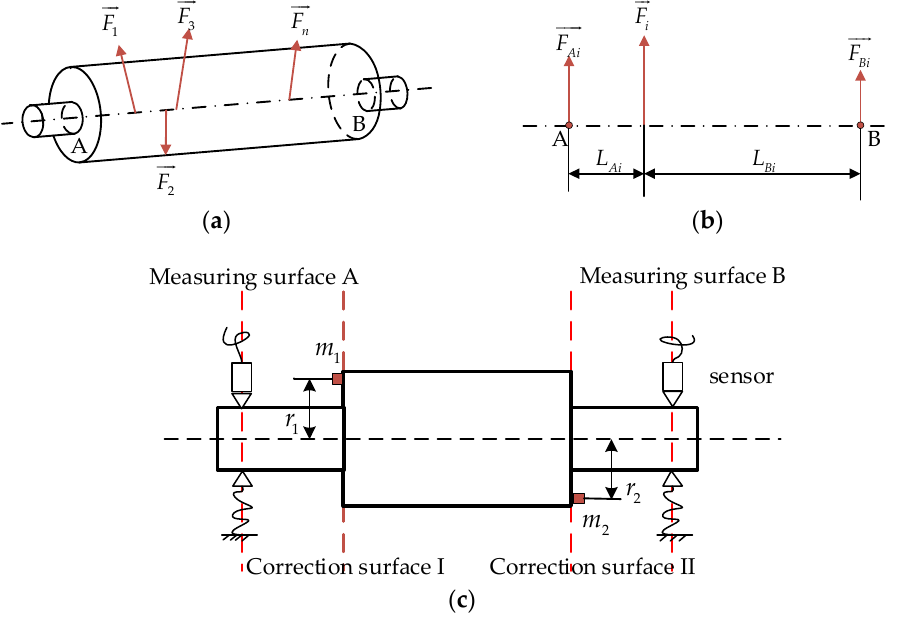
Figure 1. Principle of the dynamic balance of the rigid rotor: ( a ) rigid rotor with centrifugal forces; ( b ) equivalent force ( c ) schematic diagram of double-sided influence coefficient method.